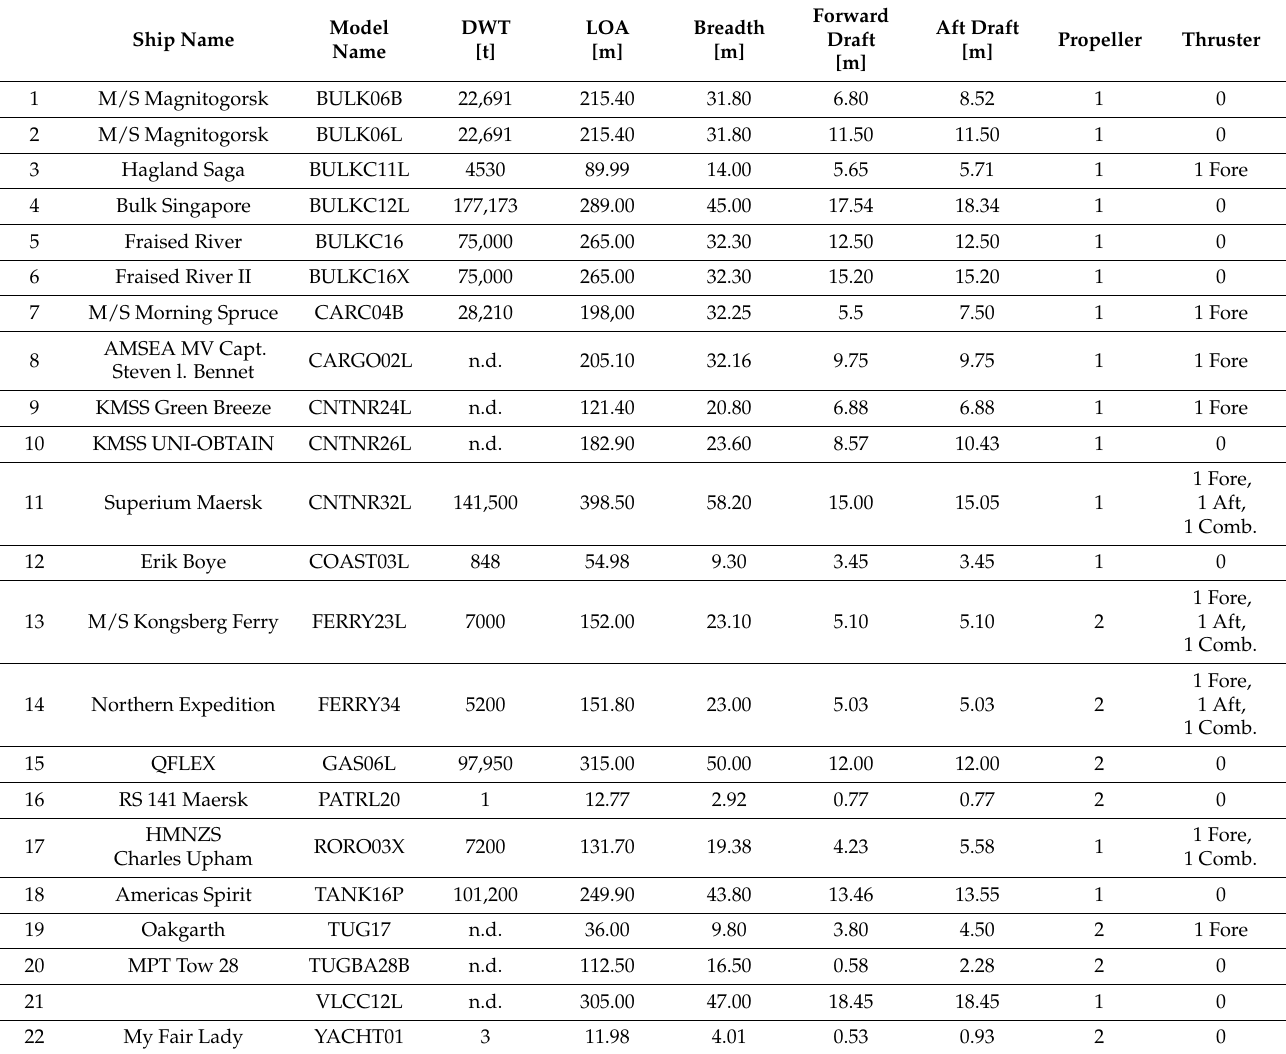
Table 1. Characteristics of the ship models available in the K-Sim Polaris simulator of